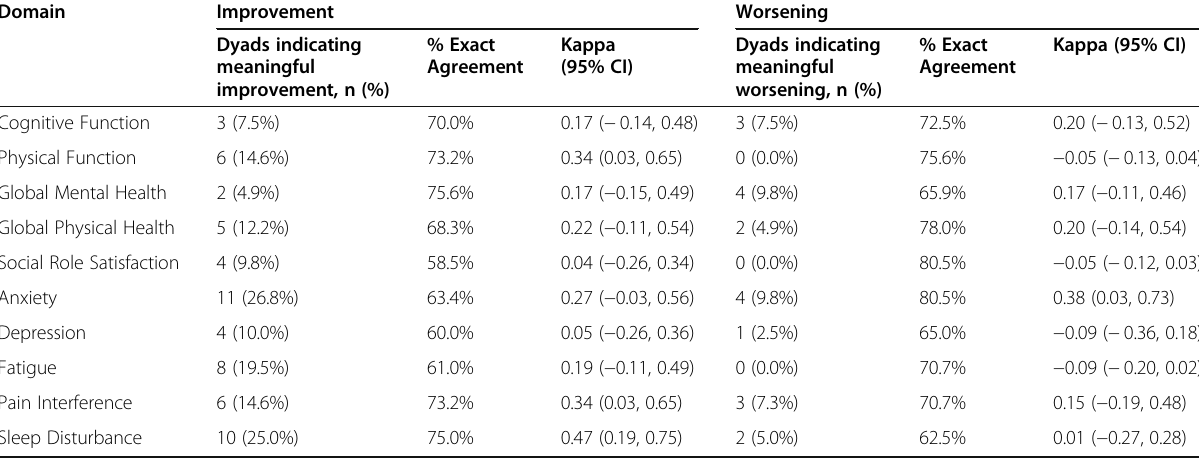
Table 3 Number of patients and proxies reporting meaningful improvement or worsening from baseline to follow-up, percent exact agreement, and kappa